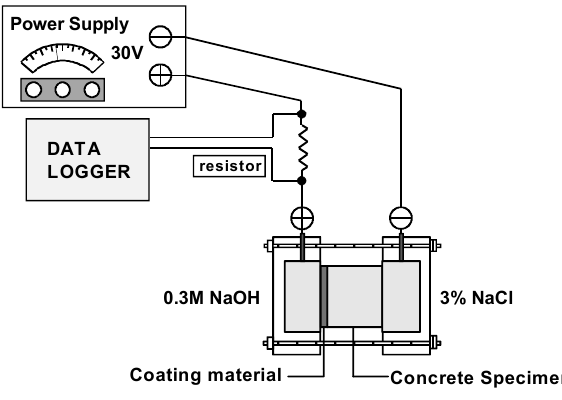
Figure 3. Test setup of chloride ion diffusion